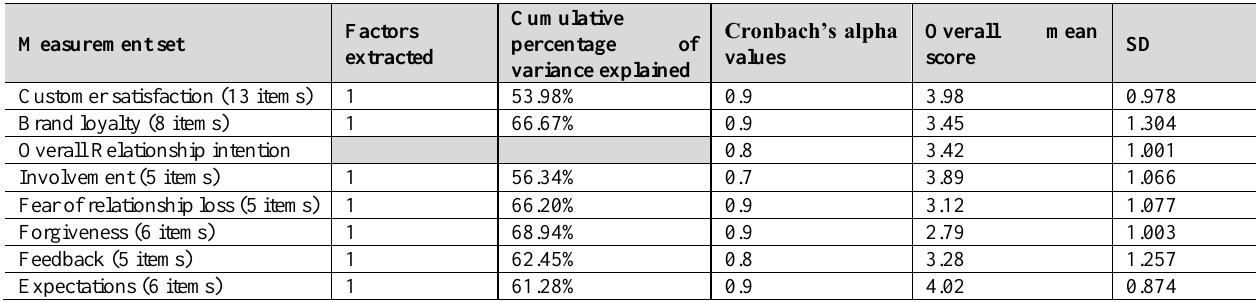
Table 1: EFA results and descriptive statistics for the measurement sets